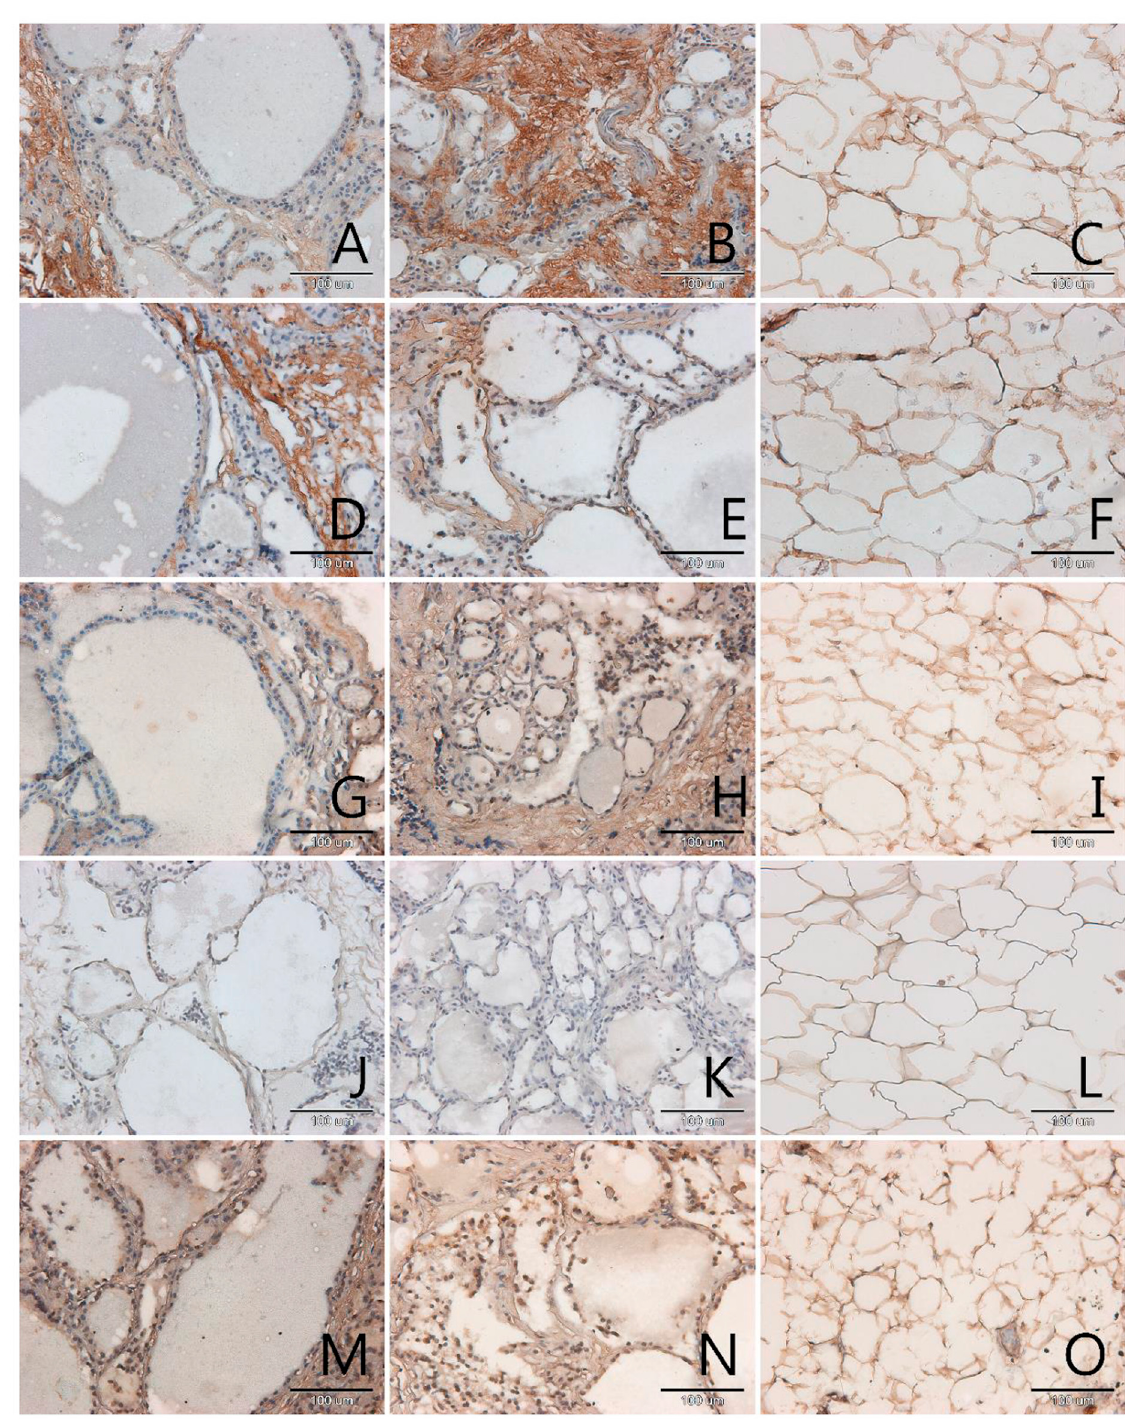
Figure 3. Immunohistochemical detection of AGEs ( A – C ), RAGE ( D – F ), SR-A ( G – I ), SR-BI ( J – L ) and NOS-3 ( M – O ) in sections of the thyroid gland with nodular goitre ( A , D , G , J , M ), in the paired control sections ( B , E , H , K , N ) and in the fatty tissue surrounding the tumor ( C , F , I , L , O ). Magnification 200× (scale bar 100 µm).